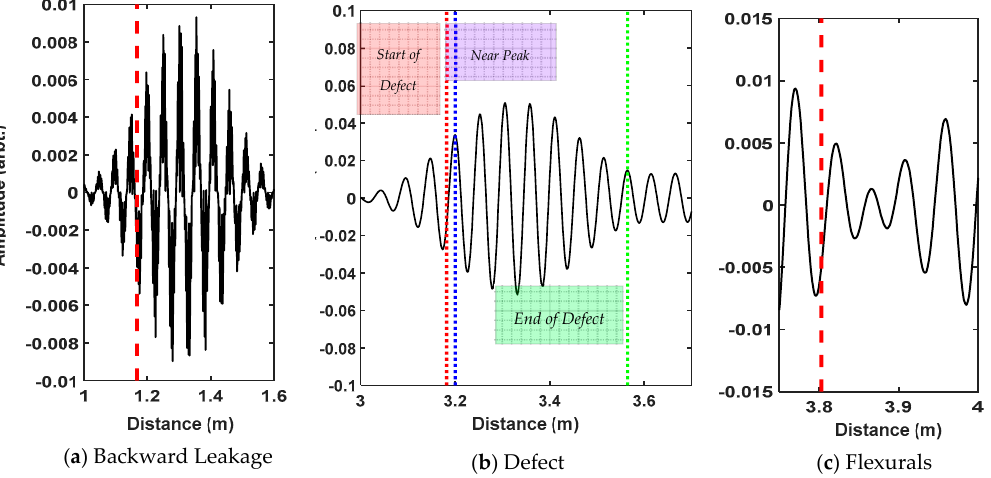
Figure 2. Temporal domain of cases (d)–(i) from Figure